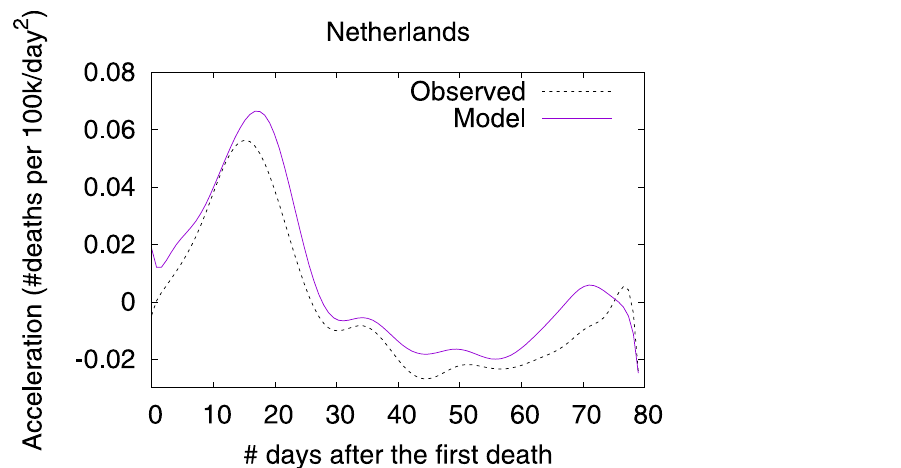
Fig 13. (Color online) projections for acceleration in Netherlands.